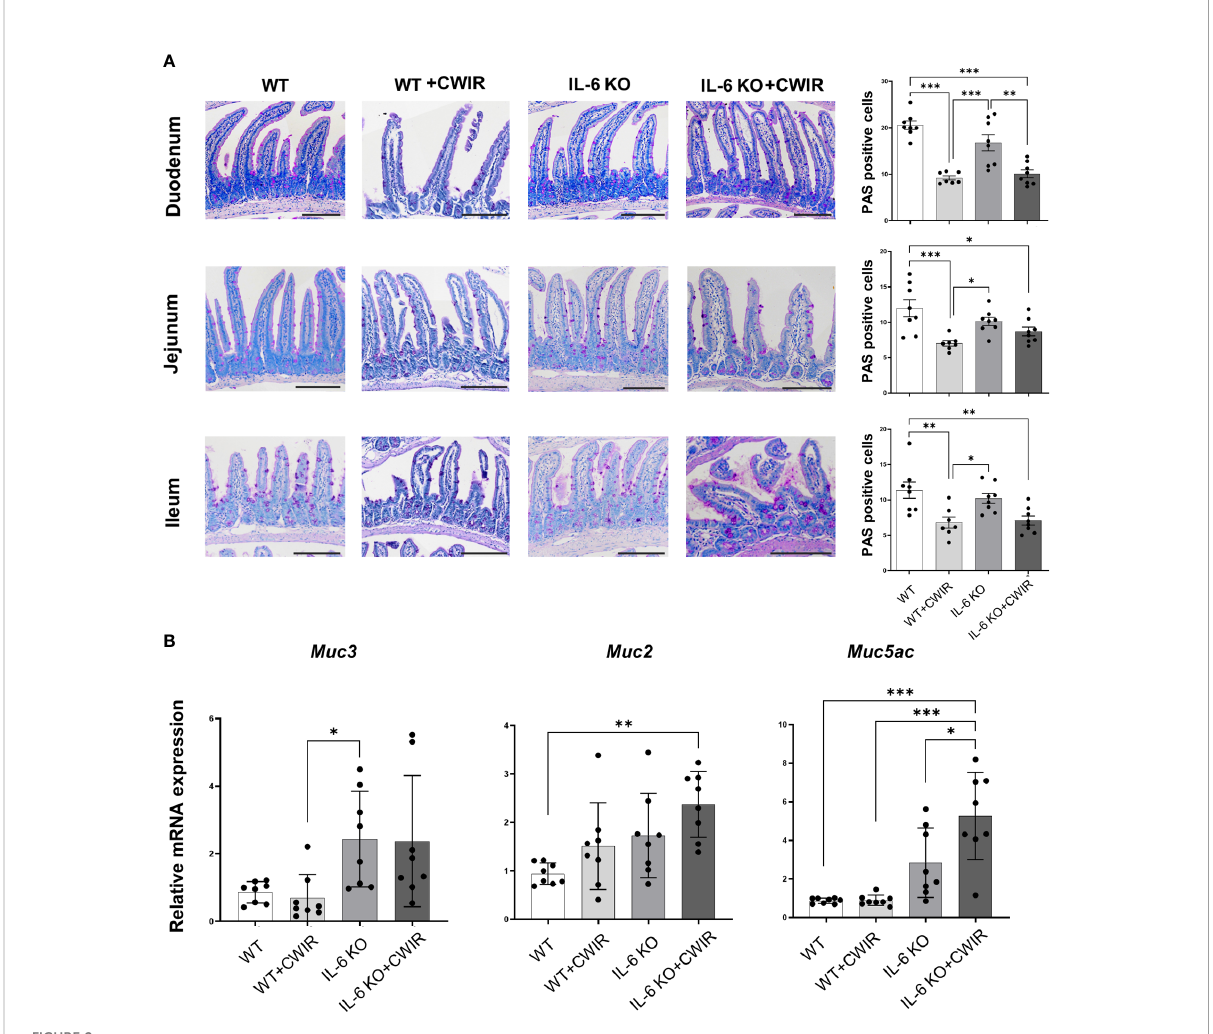
FIGURE 2 IL-6 KO alleviated the CWIR-induced decrease of goblet cells. (A), Goblet cells were stained by PAS staining. Representative images and the quanti fi cation of PAS positive cells were exhibited. The scale bar means 200 m m. N=7-8. (B), Relative mRNA levels of Muc3 , Muc2 , and Muc5ac in the jejunum among groups. N=8-10. Data analysis was performed by two-way ANOVA with the Tukey post-hoc test. * p <0.05, ** p <0.01, *** p